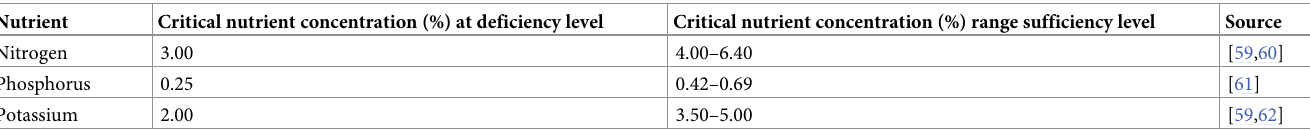
Table 1. Established critical nutrient concentration values for maize crop. Nutrient Critical nutrient concentration (%) at deficiency